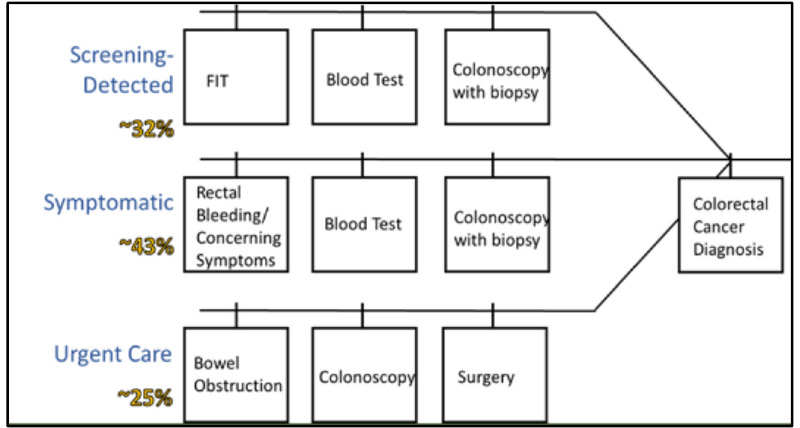
Figure 1. Preliminary diagnostic framework developed to guide data abstraction, with estimated distribution of patients across diagnostic pathways from the literature [14–19].